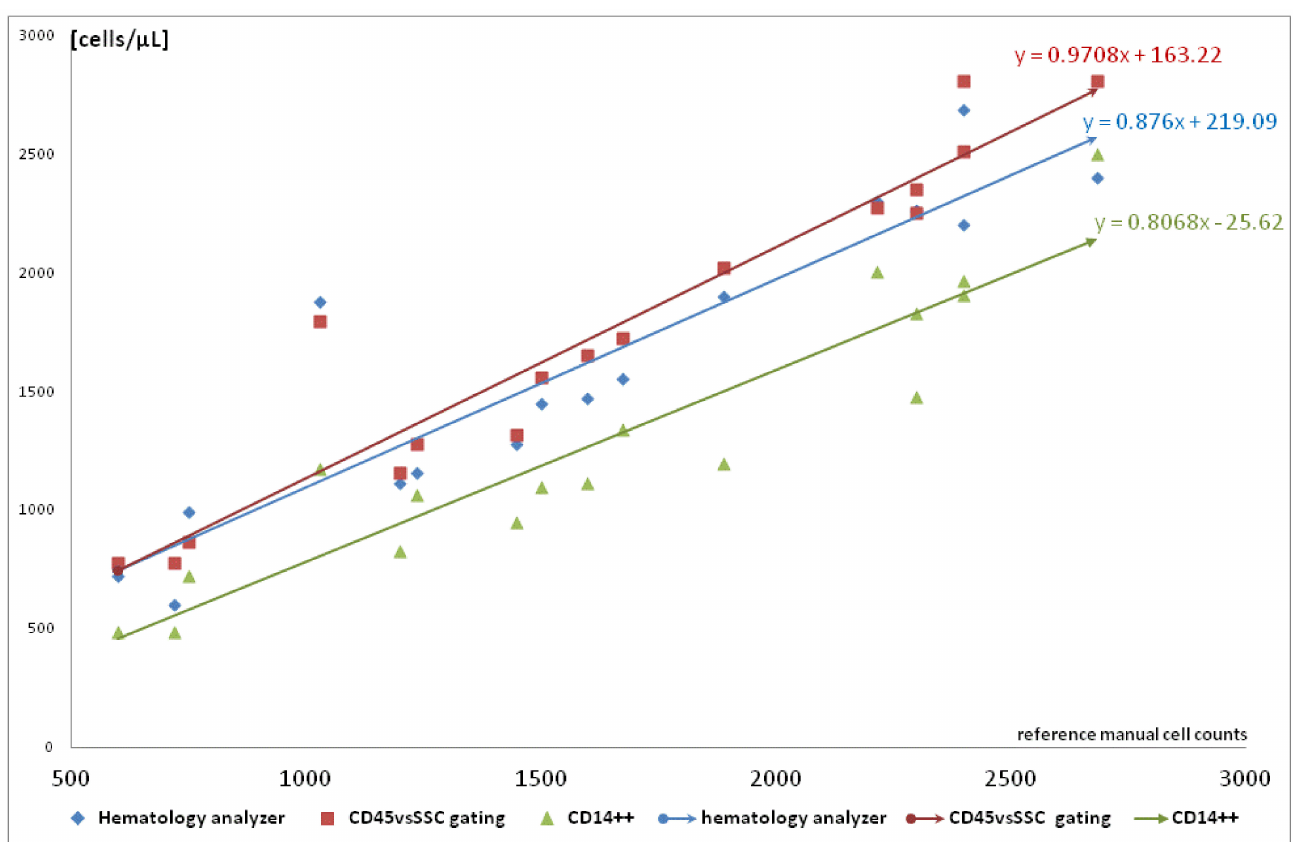
Figure 3. Regression and relationship between monocyte count obtained in manual reference method ( x axis) and two flow methods: (1) hematology analyzers, (2) cytometry with CD45vsSSC gating, or (3) CD14++ cells presented on y